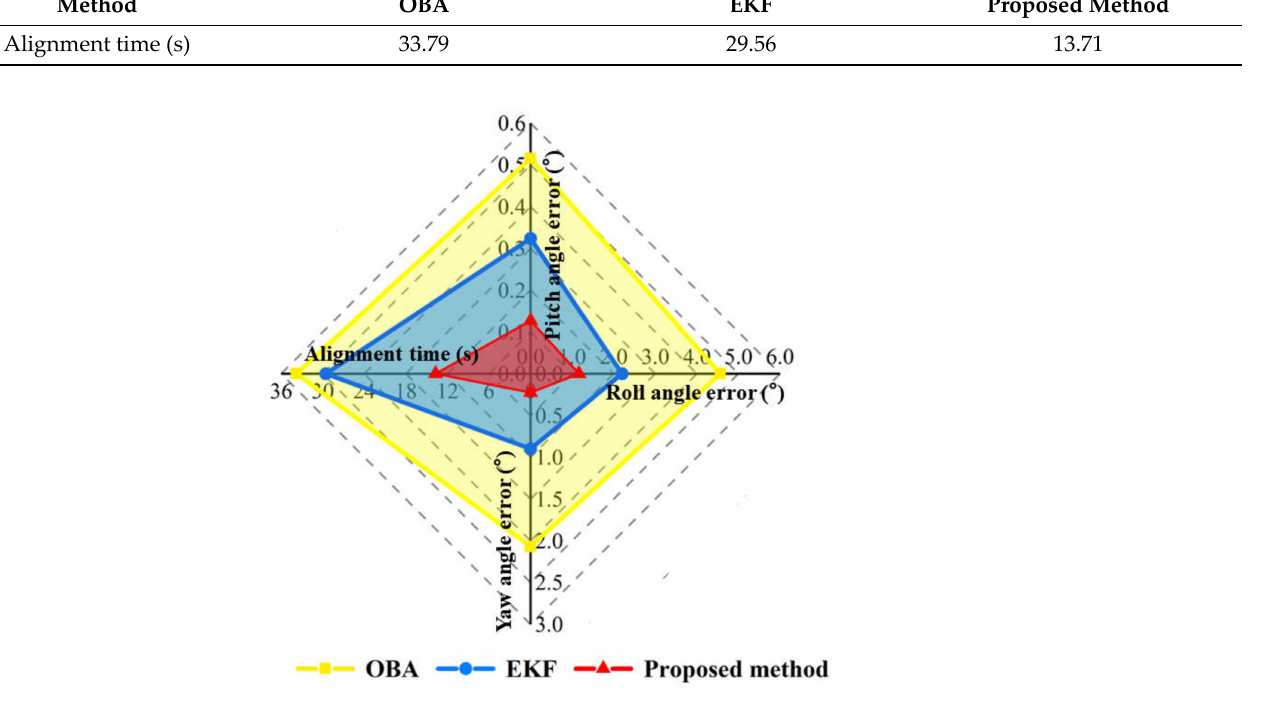
Figure 19. Radar map for statistical data (RMSE) of alignment attitude errors and alignment time of three alignment